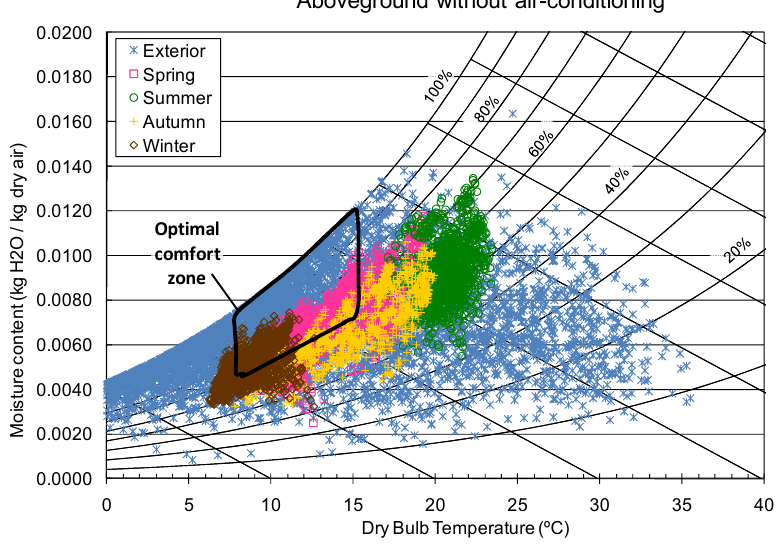
Figure 8. Indoor and outdoor hygrothermal conditions of the aboveground without air-conditioning construction. Four daily values represented (00:00, 6:00, 12:00 and 18:00) over the 2006–2009